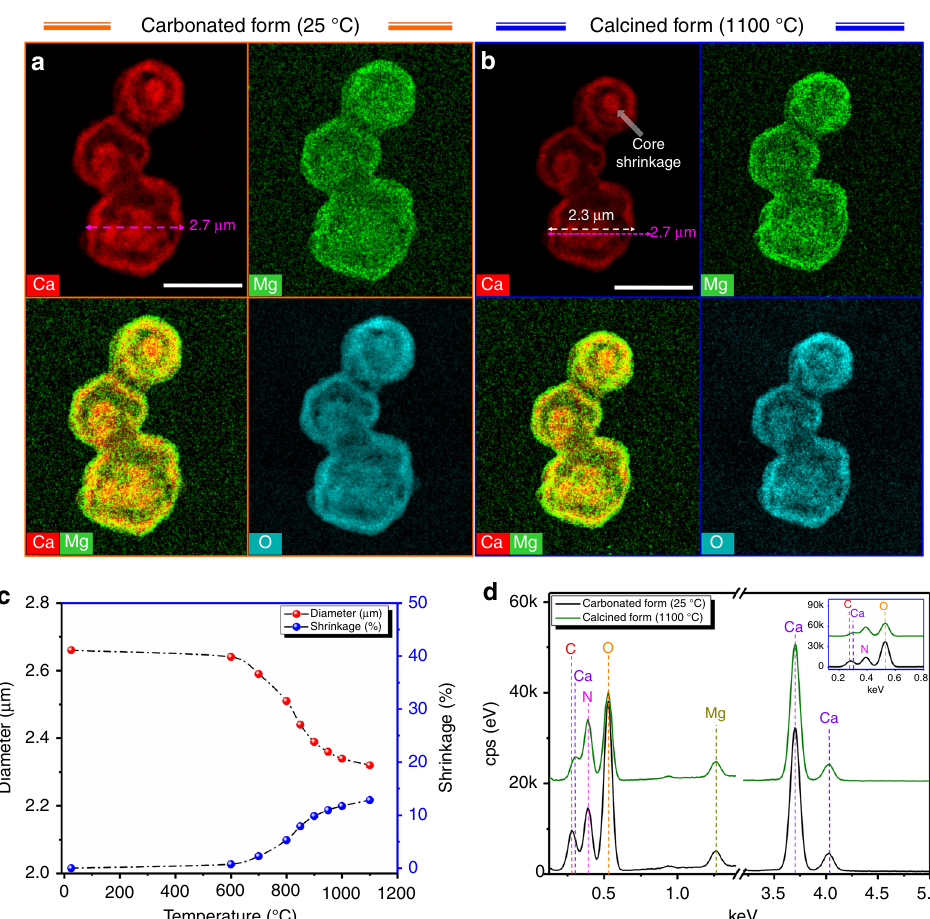
Fig. 6 Thermal stability of the multishelled structure. a STEM/EDX maps of Ca, Mg, and O in Ca85Mg15 acquired in carbonated form at room temperature. b STEM/EDX maps of Ca, Mg, and O in Ca85Mg15 acquired in calcined form at 1100 °C. c Change of the size of a microsphere as a function of temperature. d EDX spectra of Ca85Mg15 before and after calcination. Scale bars: 2 µ